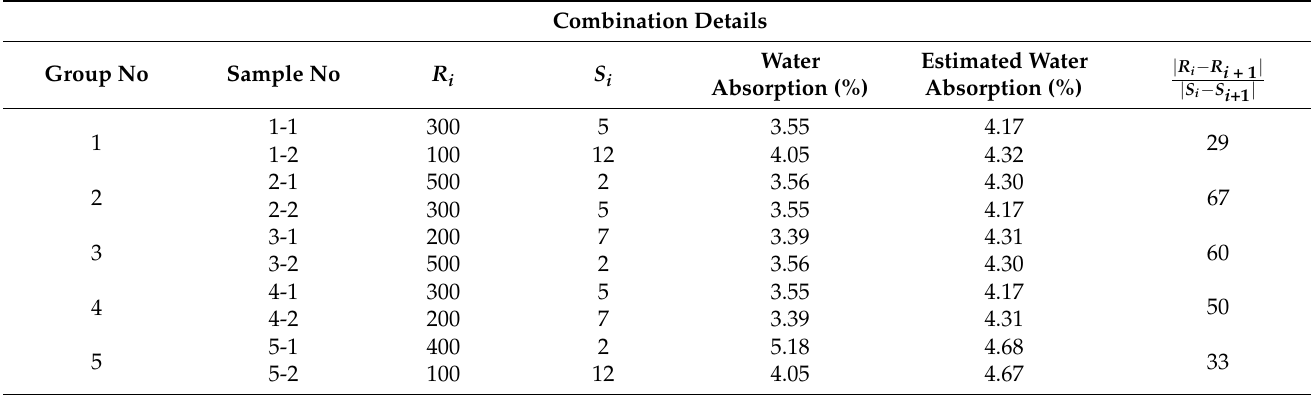
Table 5. Exemplary combinations and estimated water absorption values for 4–11.2 mm